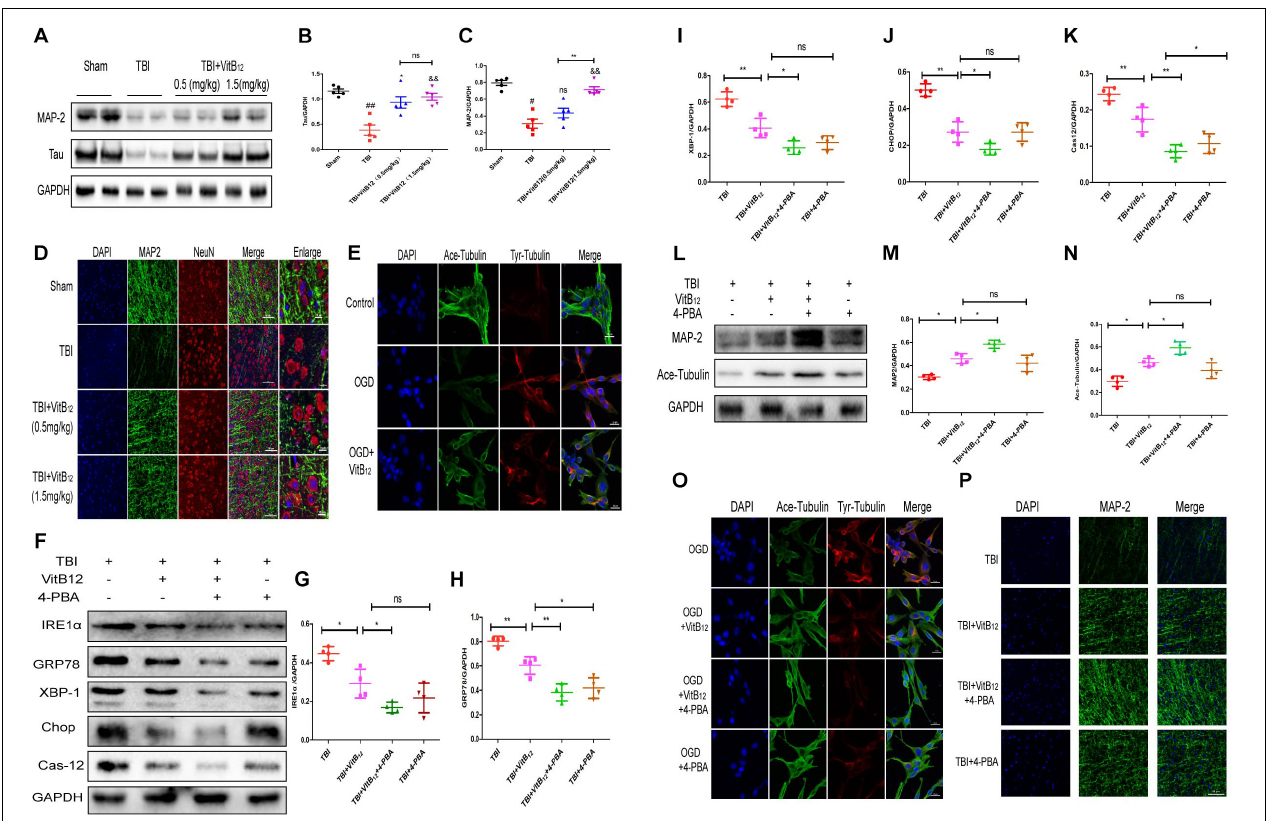
FIGURE 4 | Vitamin B12 inhibits microtubule damage through ER stress after TBI. (A) Representative western blots of the expression of MAP-2, Tau. (B,C) Quantification from (A) ## P < 0.01, # P < 0.05 vs. the sham group. ∗ P < 0.05, && P < 0.01 vs. the TBI group. ∗∗ P < 0.01 vs. the indicated group. Values represent the mean ± SEM, n = 5. (D) Representative fluorescent images depicting MAP-2 (green) with NeuN (red) in the cortex after TBI. Scale bar = 50 µ m, scale bar = 10 µ m. (E) Representative fluorescent images depicting Ace-tubulin (green) with Tyr-tubulin (red) in the PC 12 cells. Scale bar = 20 µ m. (F) Representative western blots of the expression of IRE1 α , GRP78, XBP-1, Chop, Cleaved-cas12. (G–K) Quantification from (F) ∗ P < 0.05, ∗∗ P < 0.01, and ∗∗∗ P < 0.001 vs. the indicated group. Values represent the mean ± SEM, n = 4. (L) Representative western blots of the expression of MAP – 2, Ace-tubulin. (M,N) Quantification from (L) . ∗ P < 0.05 vs. the indicated group. Values represent the mean ± SEM, n = 4. (O) Representative fluorescent images depicting Ace-tubulin (green) with Tyr-tubulin (red) in the PC 12 cells. Scale bar = 20 µ m. (P) . Representative fluorescent images depicting MAP-2 (green) in vivo . Scale bar = 50 µ